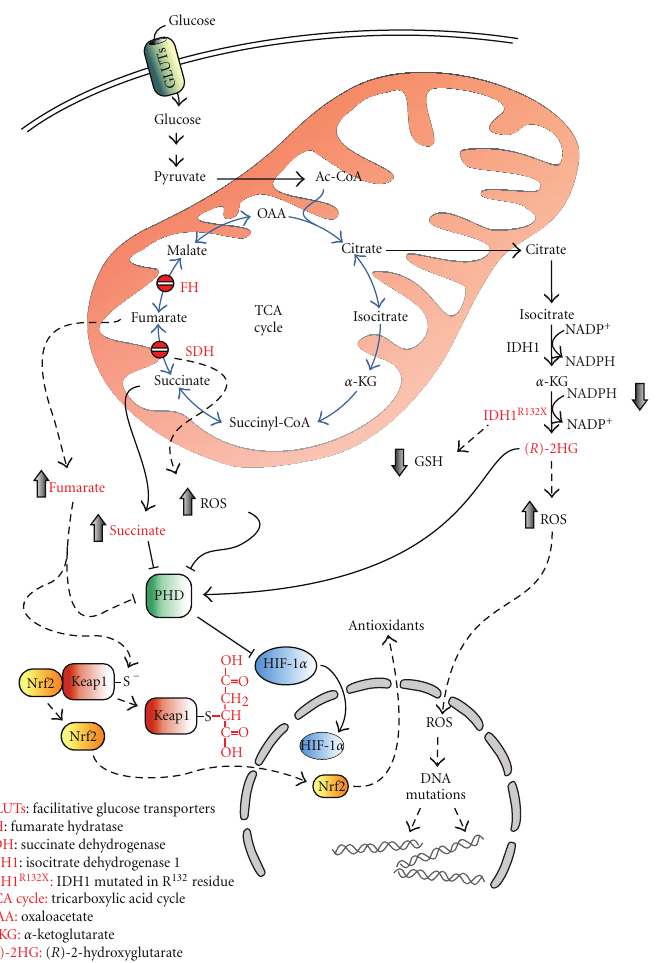
Figure 1: Redox alterations induced by TCA cycle defects. Redox alterations induced by mutations in SDH, FH, and IDH are shown. Loss of function of SDH increases ROS levels leading to DNA mutations and HIF-1 α stabilization. IDH1 and IDH2 (not shown) mutations decrease GSH and NADPH levels. ( R )-2-HG, produced by oncogenic mutations in IDH1 and IDH2, triggers ROS accumulation. Defects in FH stimulate nuclear translocation of Nrf2 and the transcription of antioxidant enzymes through the succination of Keap1. Enzymes and metabolites involved in tumor formation and redox alterations are in red. Blue arrows indicate TCA cycle reactions. Dotted arrows indicate pathways modulating cell redox